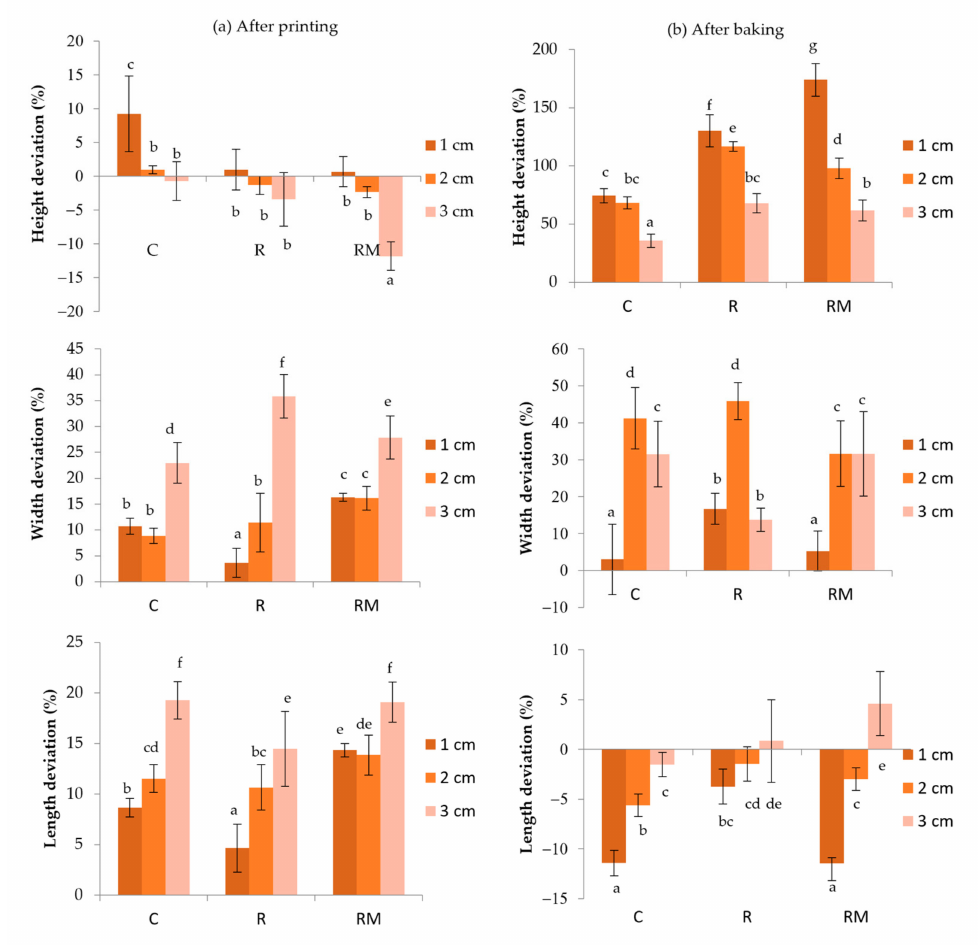
Figure 4. ( a ) Deviations of the proportions after printing samples; ( b ) Deviations of the proportions after baking samples (C, control; R, rosehip; RM, rosehip encapsulated; 1, 2, 3: height cm). Letters (a–g) indicate homogeneous group according to ANOVA ( p <